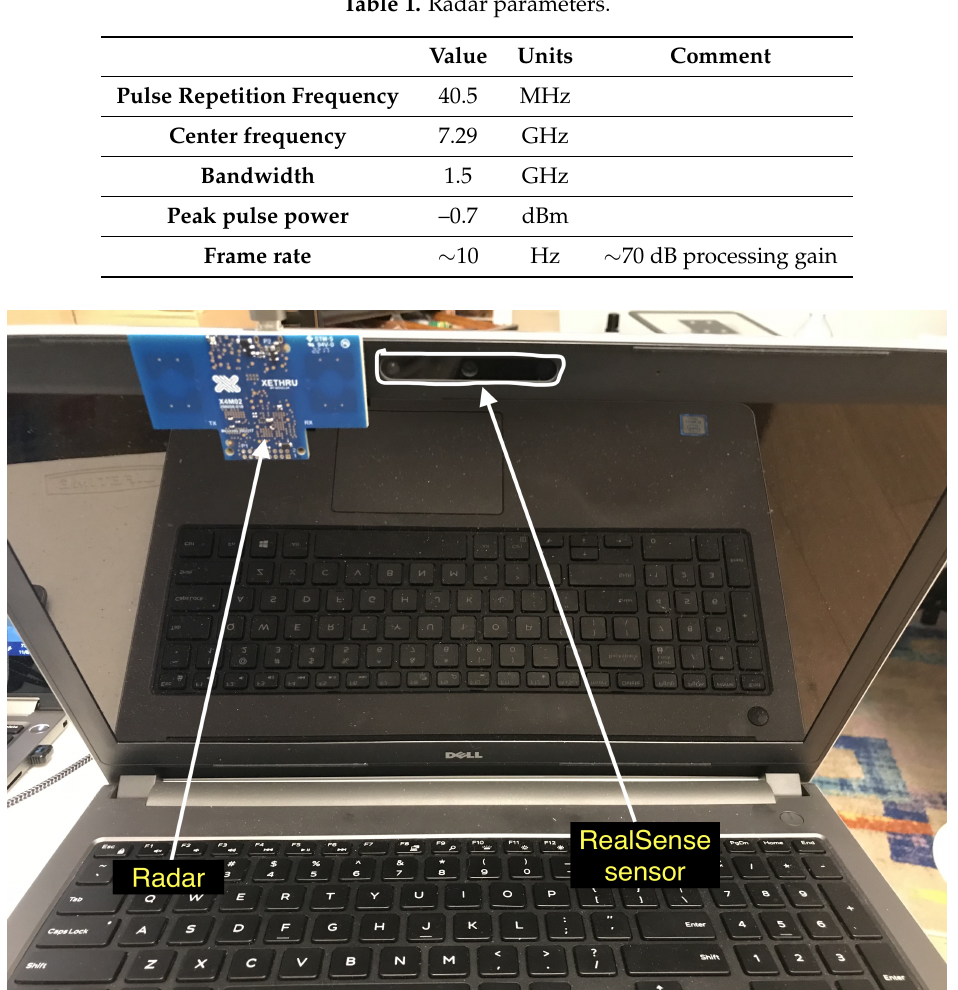
Table 1. Radar parameters.